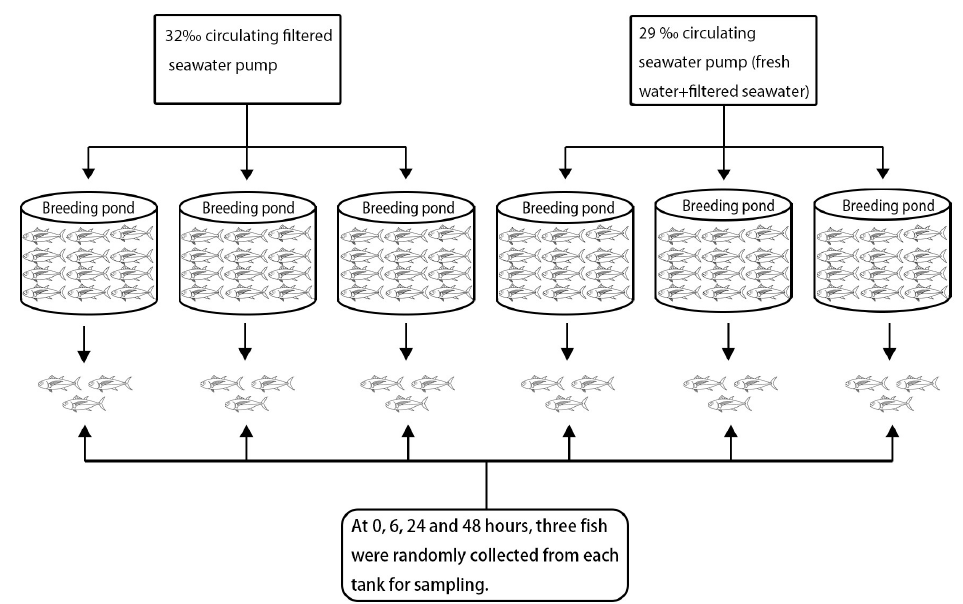
Figure 1. Experimental design of the effect of salinity change on the antioxidant capacity of juvenile yellowfin tuna ( Thunnus albacares ).